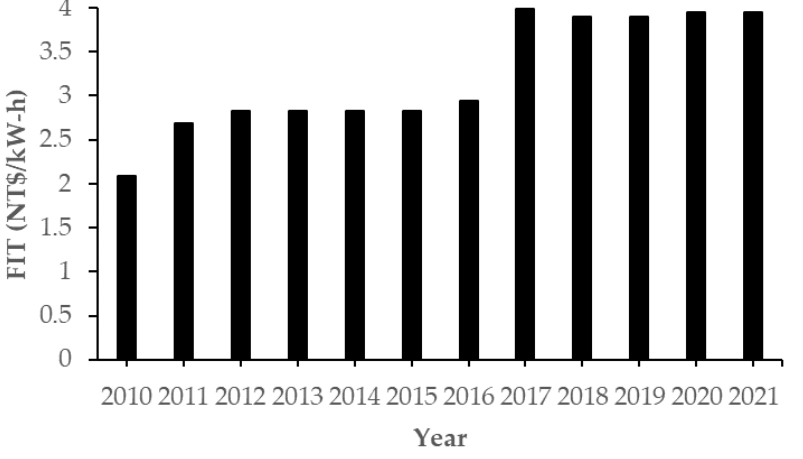
Figure 7. Feed-in tariff (FIT) rates of biomass-to-electricity in Taiwan since